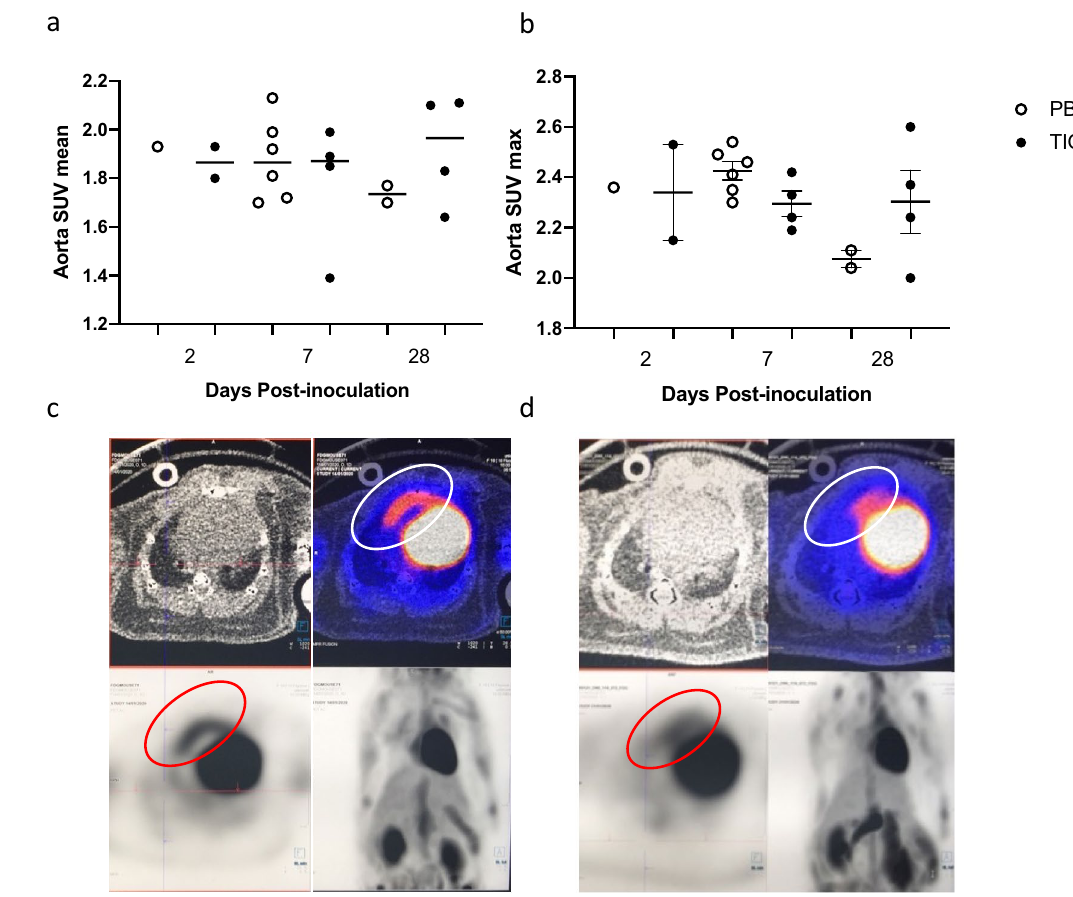
Figure 4. FDG uptake in the aortic arch. TIGR4- and PBS-inoculated mice underwent fluorodeoxyglucose positron emission tomography (FDG-PET) imaging at 2-, 7- or 28-days post-inoculation. The FDG standardised uptake value (SUV)-mean ( a ) and -max ( b ) were evaluated for each mouse. No significance was observed. Representative images of TIGR4- ( c ) and PBS-inoculated mice ( d ), respectively. Sagittal views with the red and white circles present fluorodeoxyglucose uptake in the ascending